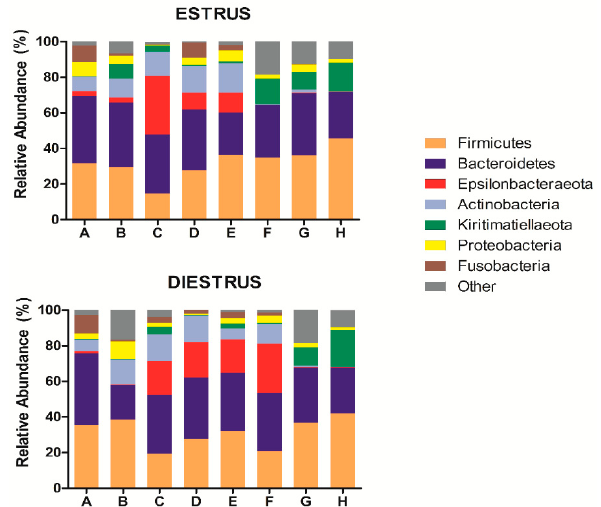
Figure 1. Phylum taxonomic relative abundance in individual mares in estrus and diestrus (only taxa with a mean relative abundance > 1.5% at estrus or diestrus are represented). The letters in the x axis correspond to each individual mare.